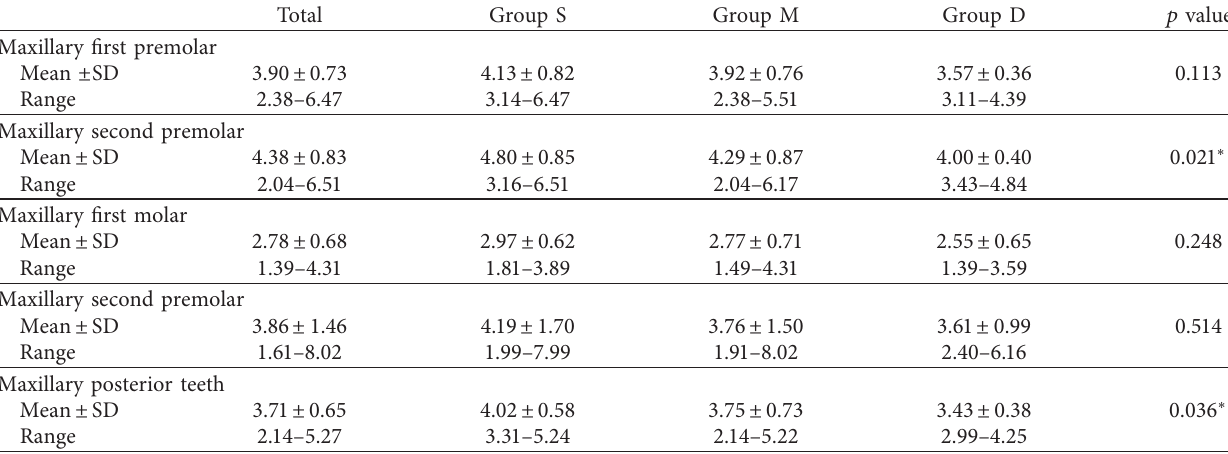
Table 2: Palatal tissue thickness data of all posterior teeth from 3 different palatal vault angle types.